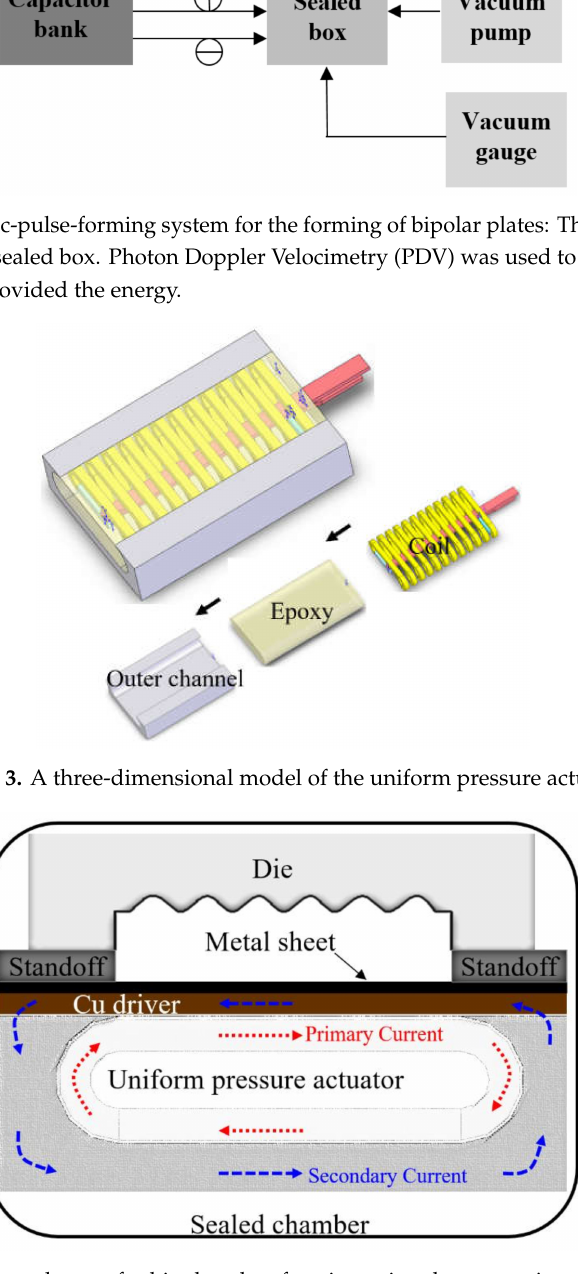
Figure 4. The experimental setup for bipolar plate forming using the magnetic pulse forming